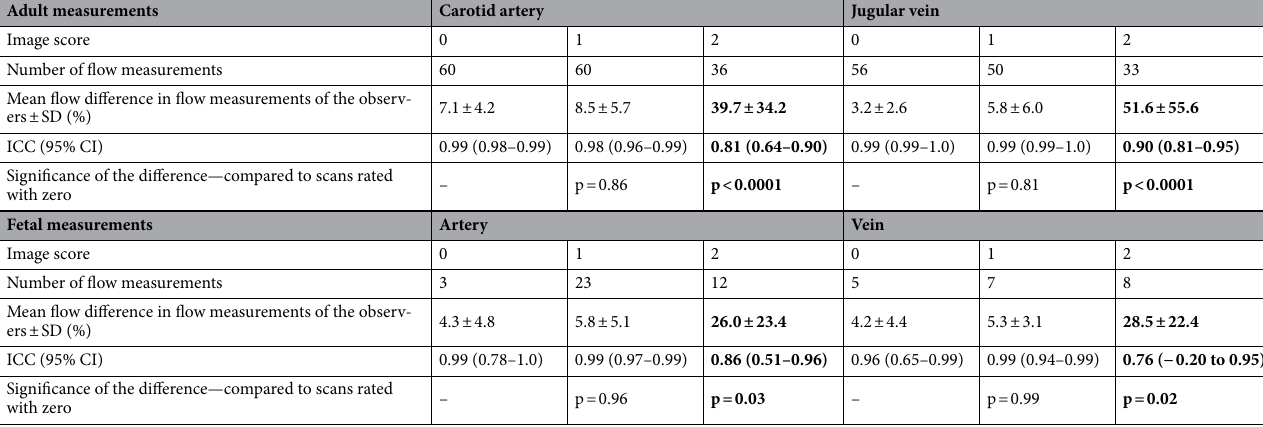
Table 2. Inter-observer variability in venous and arterial flow measurements in adult and fetal vessels. ICC intra class correlation, SD standard deviation, CI confidence interval. Significant values are in bold.